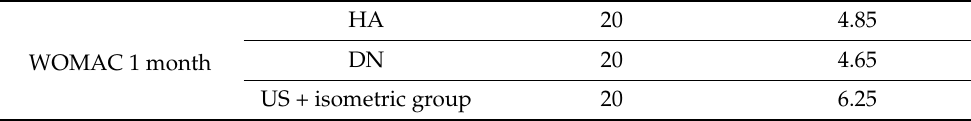
Table 8. WOMAC 1 month. Difference US + isometric group vs. HA group and DN group.